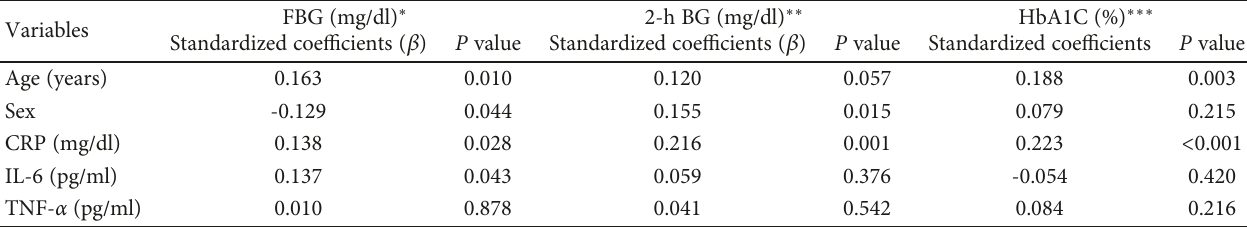
Table 2: Multiple regression analysis of blood glucose indices vs. 5 independent variables among 248 subjects at baseline. Variables